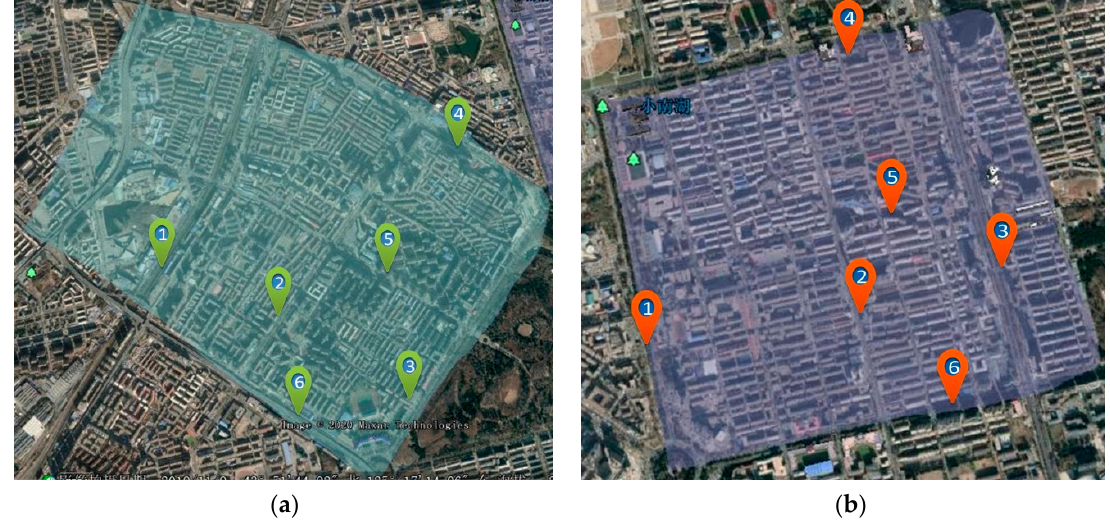
Figure 2. Backgrounds urban high-density areas of model building in simulator. ( a ) Hongqi district center in Changchun; ( b ) Guilin district center in Changchun.